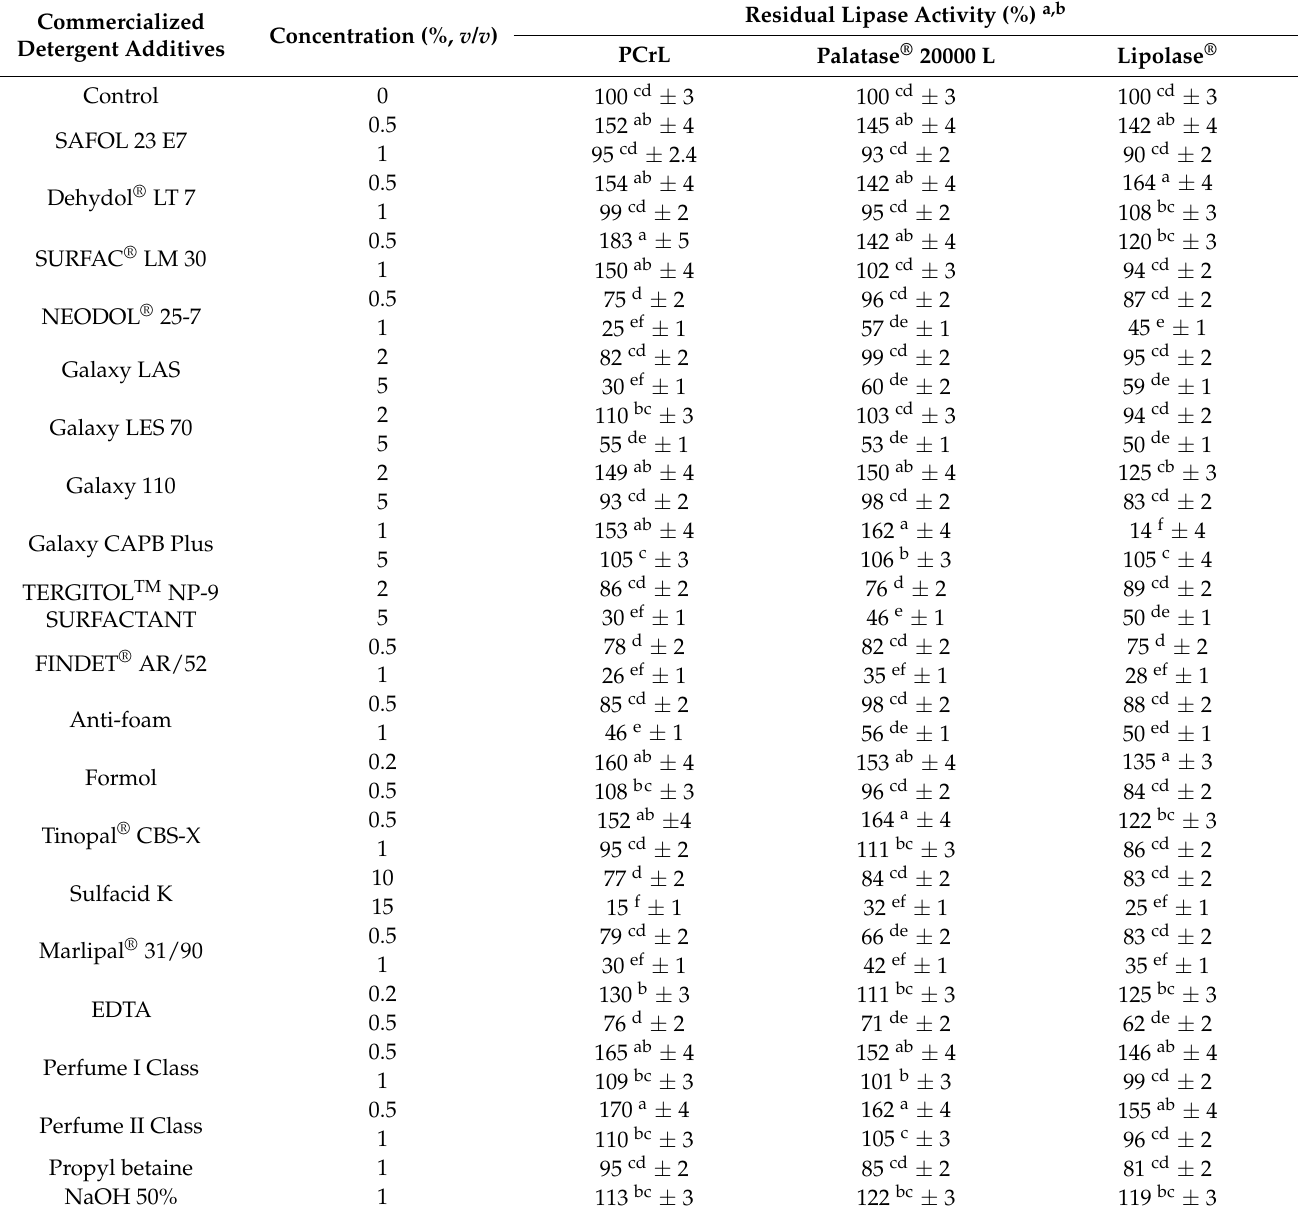
Table 5. Stability of alkaline lipases PCrL, Palatase ® 20000 L, and Lipolase ® with several commercial- ized detergent